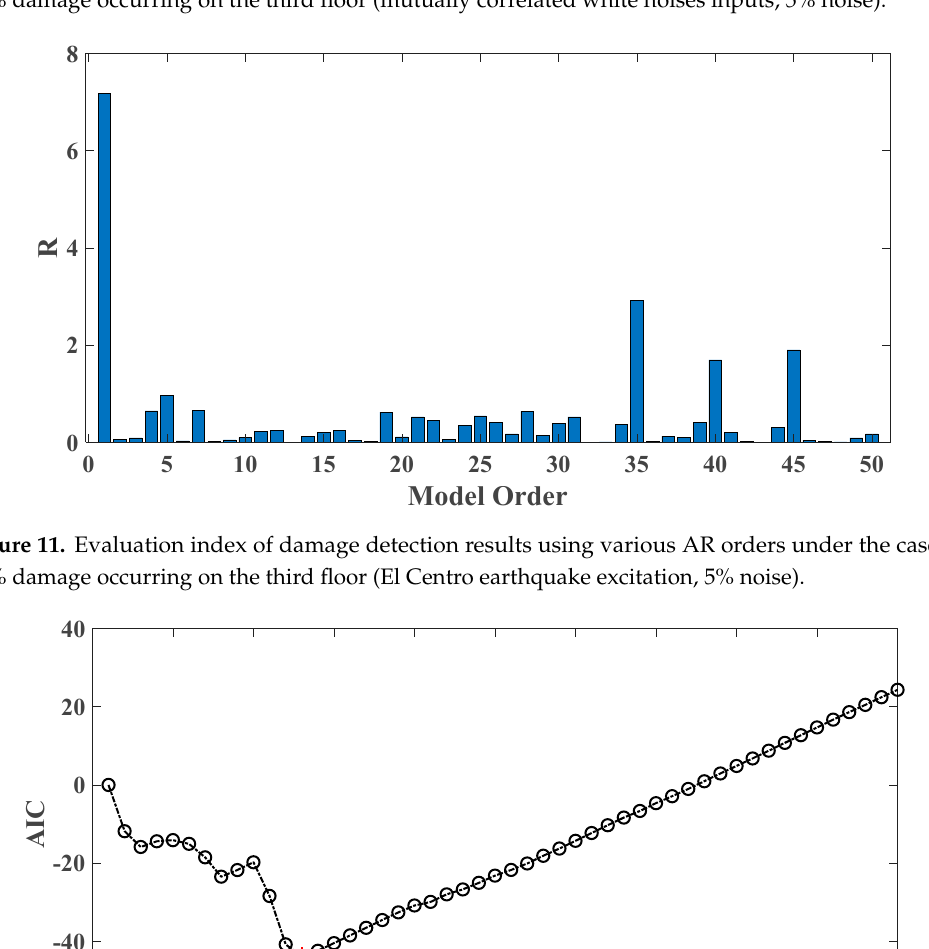
Figure 13. AIC of an AR model for the third floor response under the case of 30% damage occurring on the third floor (El Centro earthquake excitation, 5% noise). In a practical health monitoring system, the time series response of all floors are generally recorded at regular intervals, with two minutes, one hour or one day. In order to investigate the feasibility of the proposed damage indicator embedded in the structural health monitoring system to detect system changes, numerical simulations of continuously detecting damage of the abovementioned shear building structure at the same time intervals are conducted. Three hundred data sets are simulated and each comprises 4000 sampled data (at a sampling period of 0.01 sec, hence a total of 40 sec for each data set). The former 50 data sets are simulated acceleration time histories in undamaged state, while the latter 250 ones are in damaged states with different damage extent (10% through 50%). Given the scenario of the fifth story damage as an example, the identification results are shown in Figure 14. During the first 50 data sets, since the structural state does not change, the damage indicator is close to zero. As for the later 250 data sets, it shows a clear damage quantification with the growing damage degrees. As a result of the estimated deviation of AR poles for different data sets, it shows a continuous undulation during the undamaged process and the damaged process. Still, overall the damage indicators fluctuate at a certain mean value and the whole trend indicating the sudden system change is distinct. Thus, the proposed damage indicator is promising to contribute to the design of SHM systems.